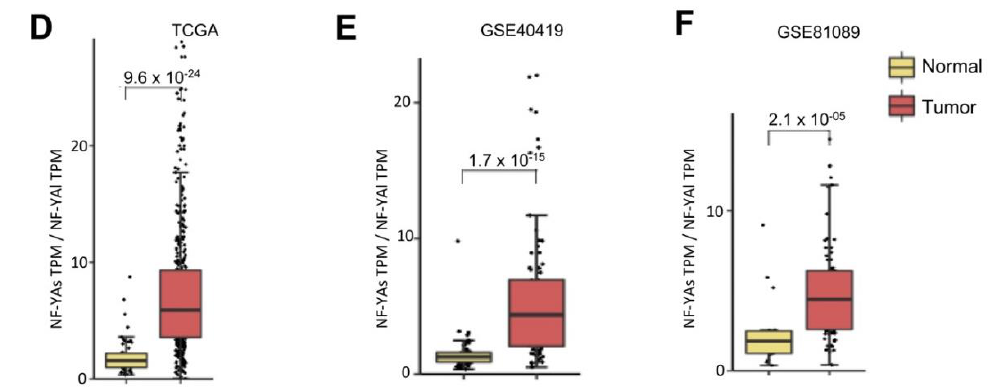
Figure 2. Cont . Figure 2. NF-YA short isoform was overexpressed in LUAD. ( A ) Box plots of expression levels of NF-YAs (“short”) and NF-YAl (“long”) in the TCGA LUAD dataset. ( B ) Same as ( A ), except that the GSE40419 dataset was analyzed. ( C ) Same as ( A ), except that LUAD tumors of the GSE81089 dataset were used. ( D ) Relative ratios of NF-YAs / NF-YAl in TCGA-LUAD. ( E ) Same as ( D ), except that the GSE40419 dataset was analyzed. ( F ) Same as ( D ), except that the LUAD tumors of the GSE81089 dataset were used.